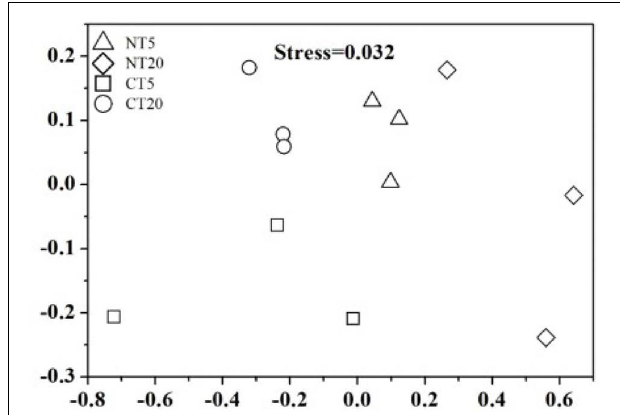
FIGURE 2 | NMDS ordinations of soil fungal communities under NT and CT.